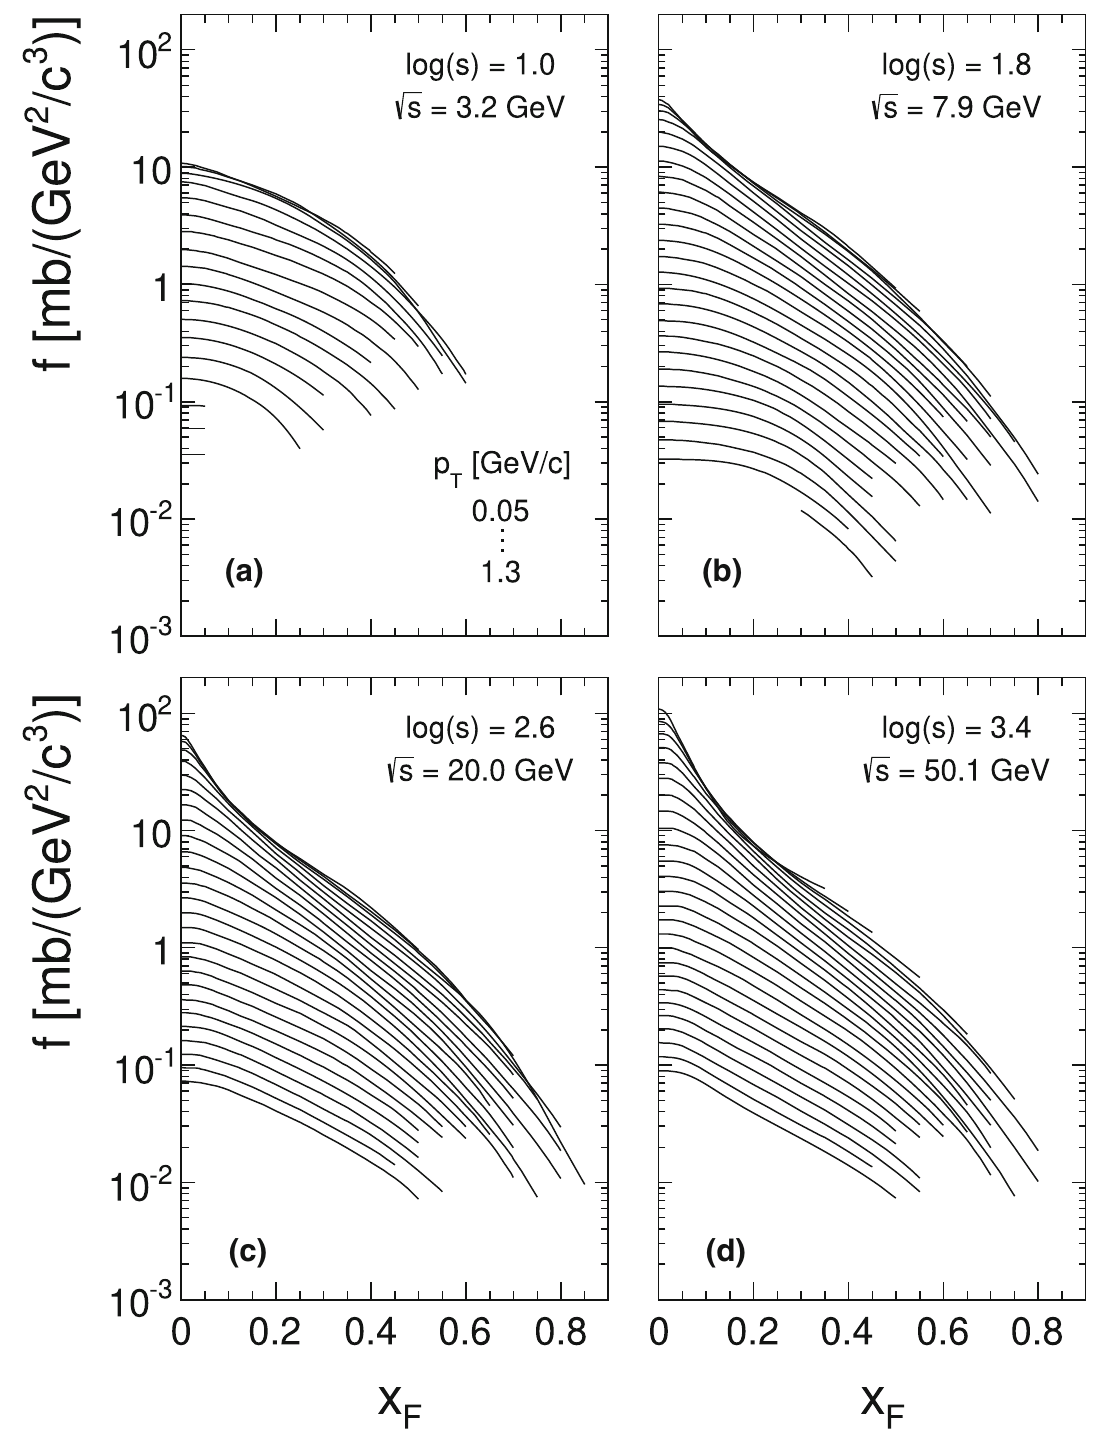
√ s = 3.2, 7.9, 20.0 and 50.1 GeV. The full lines